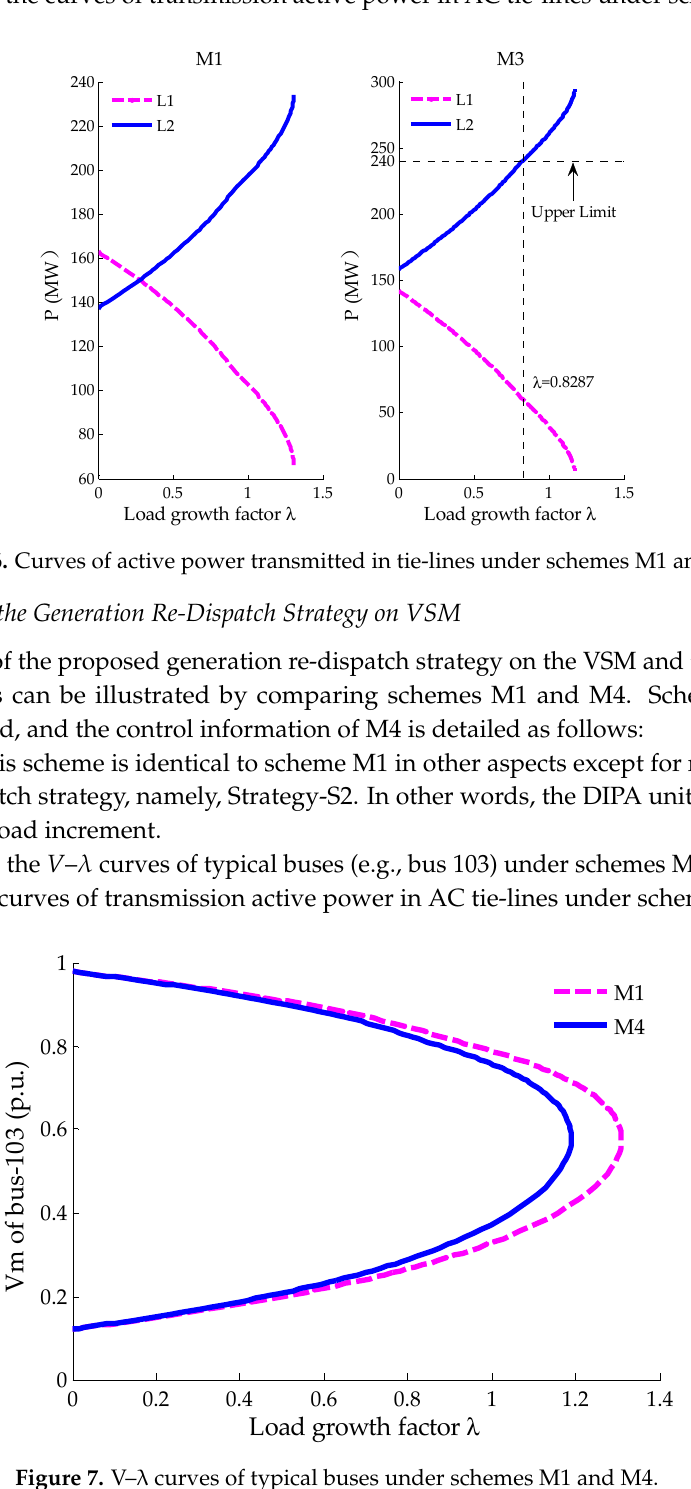
Figure 7. V– λ curves of typical buses under schemes M1 and M4.